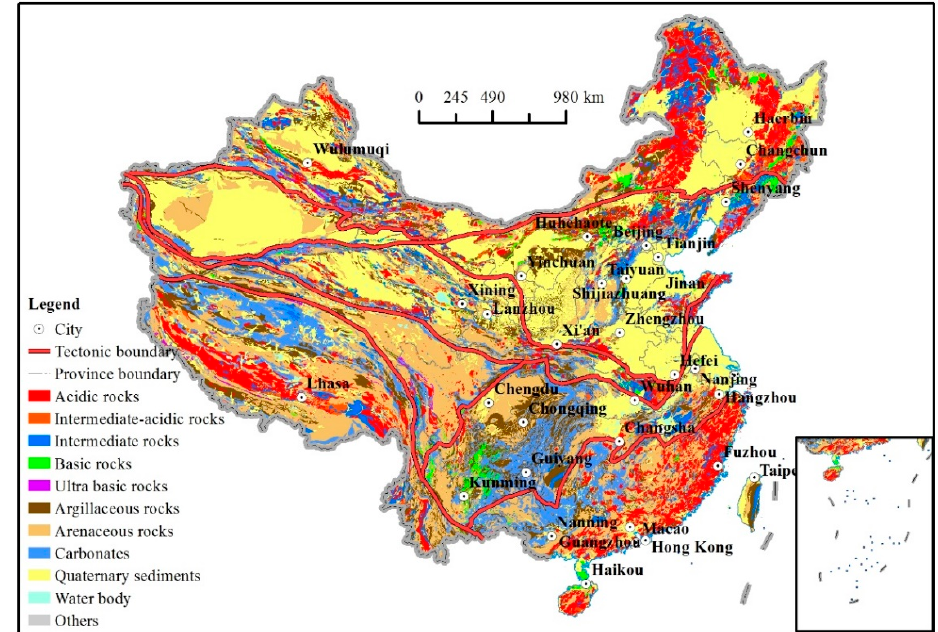
Figure 6. Lithology distribution and tectonic boundary map of China (lithology distribution based on Ye et al. [25], tectonic boundary redraw from Ren et al.